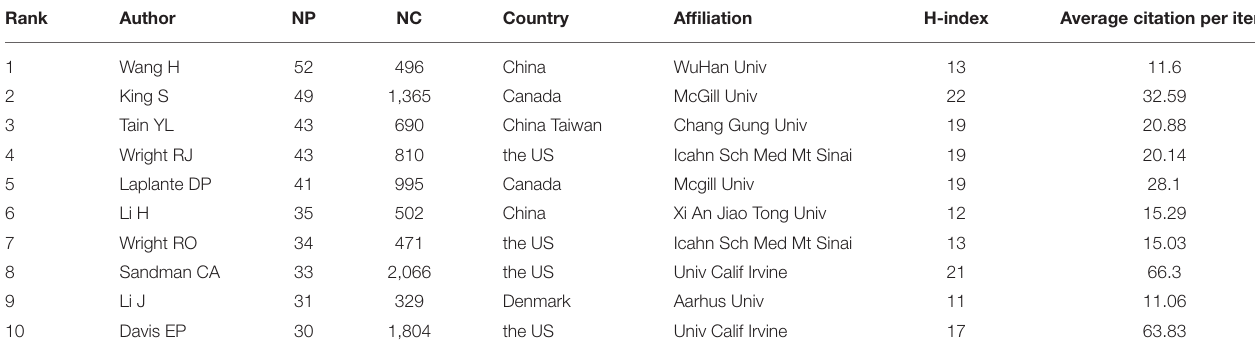
TABLE 3 | Top 10 authors with the most publications.